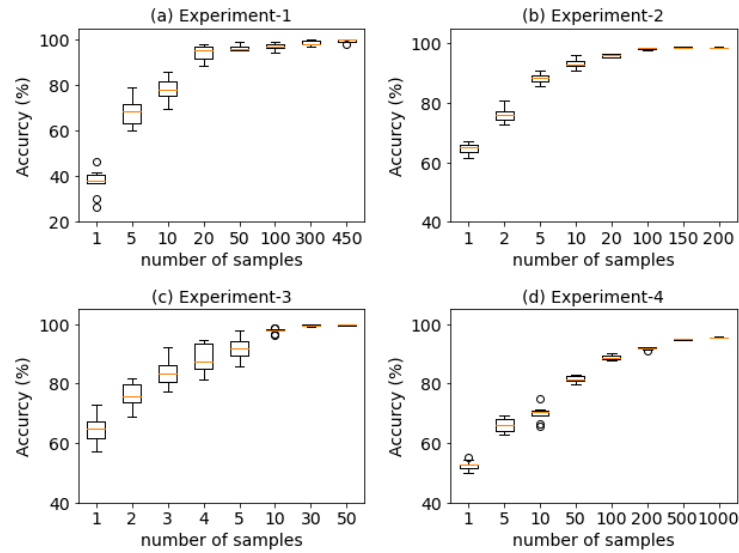
Figure 17. Effects of the size of training samples on classification performance.